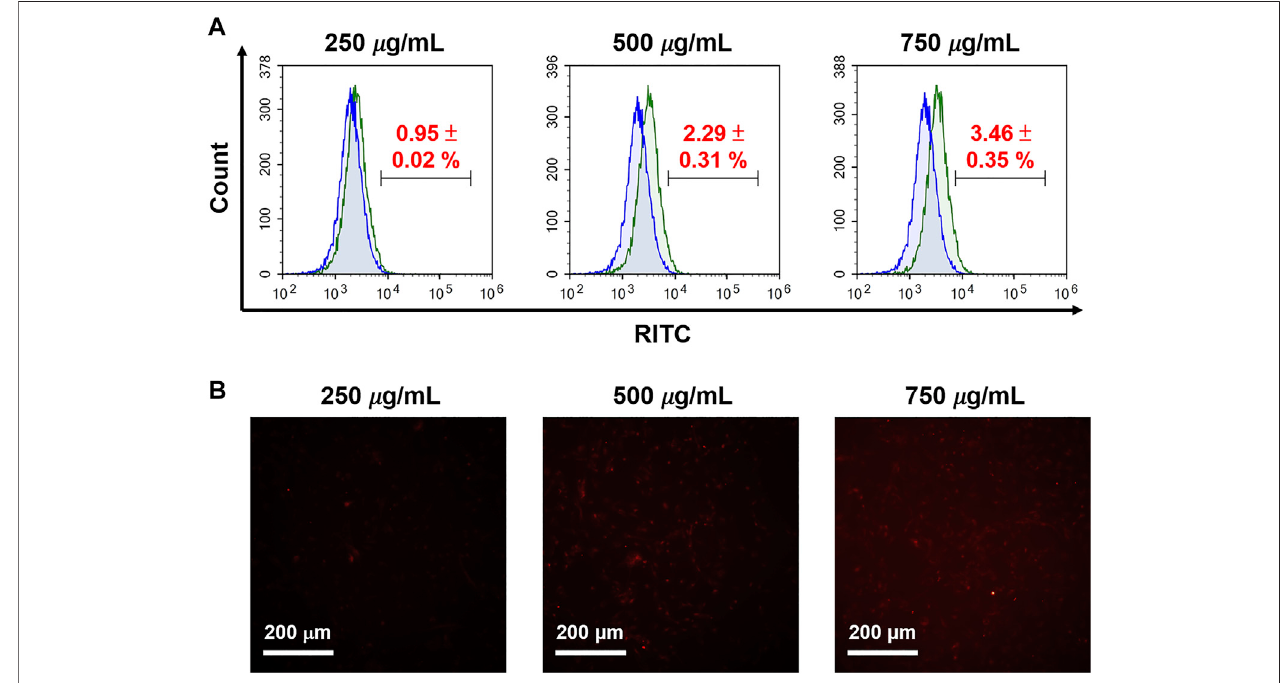
FIGURE 8 | Evaluation of RITC-conjugated N4-MSN 50 @PEG/THPMP for cell uptake. U87-MG cells treated with different concentrations of N4-RMSN 50 @PEG/ THPMP (250, 500, and 750 μ g/ml) for 24 h. (A) Flow cytometry analysis and (B) fl uorescence microscopy imaging for cell uptake in 10% serum-containing medium. Scale bars: 200 μ